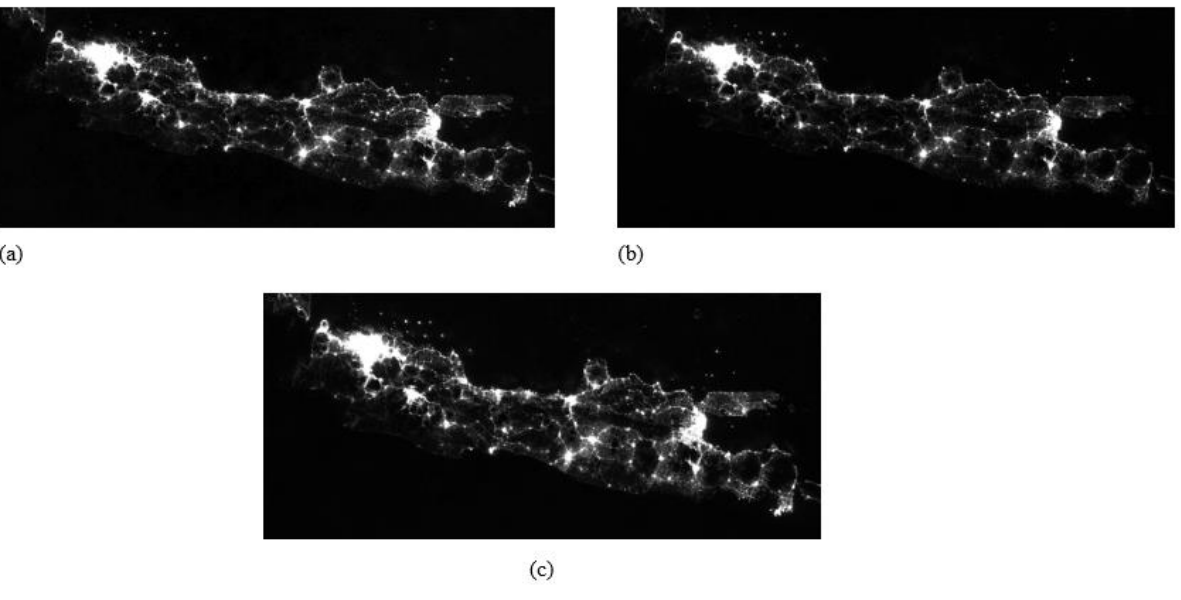
Figure 1. Java Island at night as captured by VIIRS from year to year: (a) 2015 (b) 2017 (c)